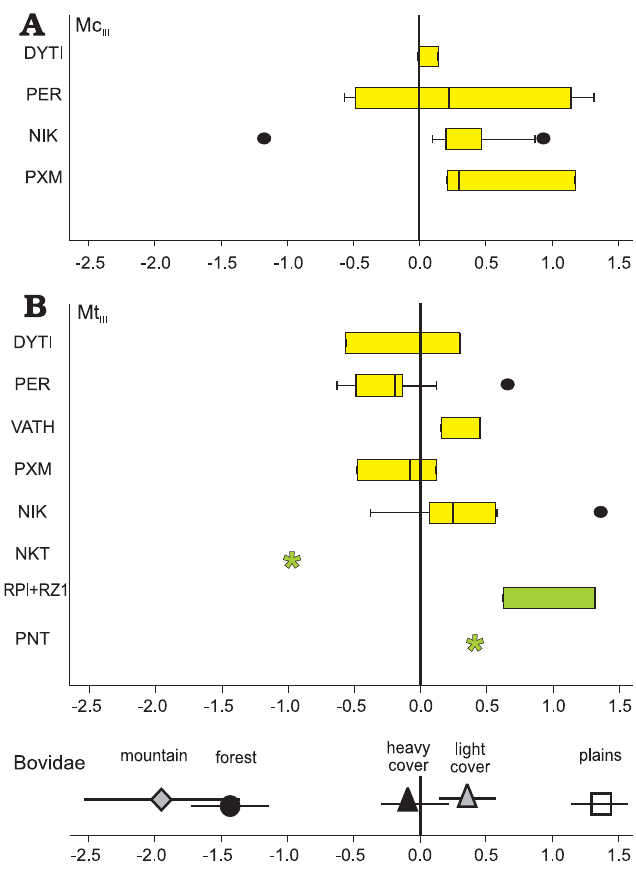
Fig. 14. Habitat scores for the third metacarpals ( A ) and metatarsals ( B ) of Hipparion macedonicum from the various Greek localities; the habitat scores are calculated following Scott (2004). Dots indicate outliers and asterisks single